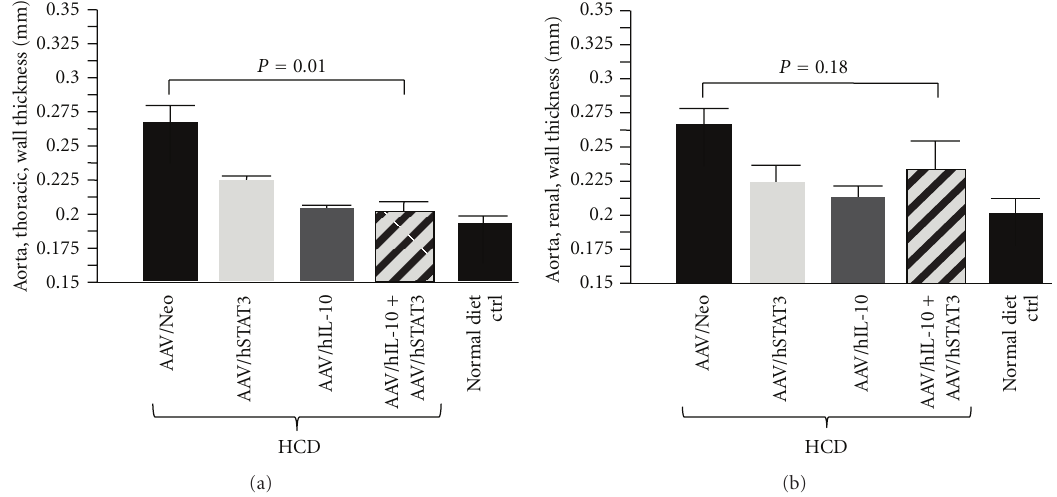
Figure 6: Analysis of the aortic wall thickness by HRUS. HRUS was used to measure the wall thickness of the aorta. (a) shows quanitification of the thoracic region of the aortas in 3–5 animals from each animal group. Note that the hSTAT3-, hIL-10-, and hSTAT3-plus-hIL-10- treated animals had thinner wall thicknesses than the Neo-treated animals, indicating significant e ffi cacy. (b) shows quantification of the renal region of the aortas in 3–5 animals from each animal group.